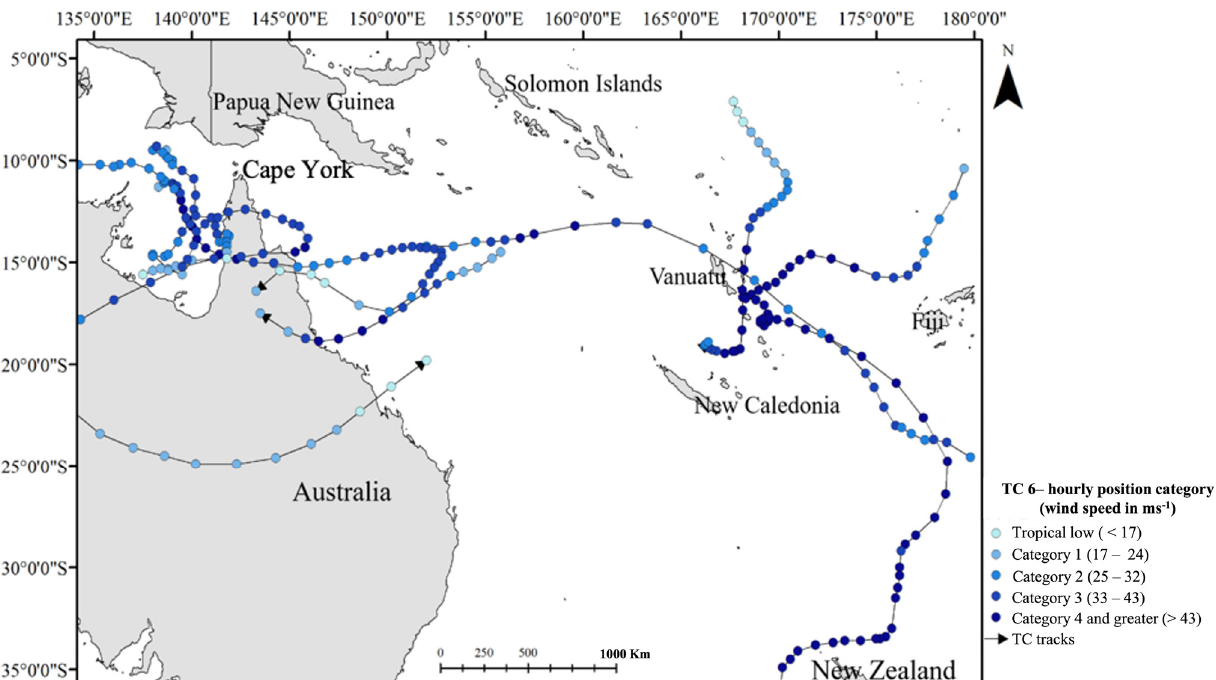
Figure 12. Geographic distribution of incorrectly classified cases for both mainland and islands from the testing data. For the mainland cases, most events cluster over the Gulf of Carpentaria region and for the island cases, most events cluster over the Vanuatu Islands .